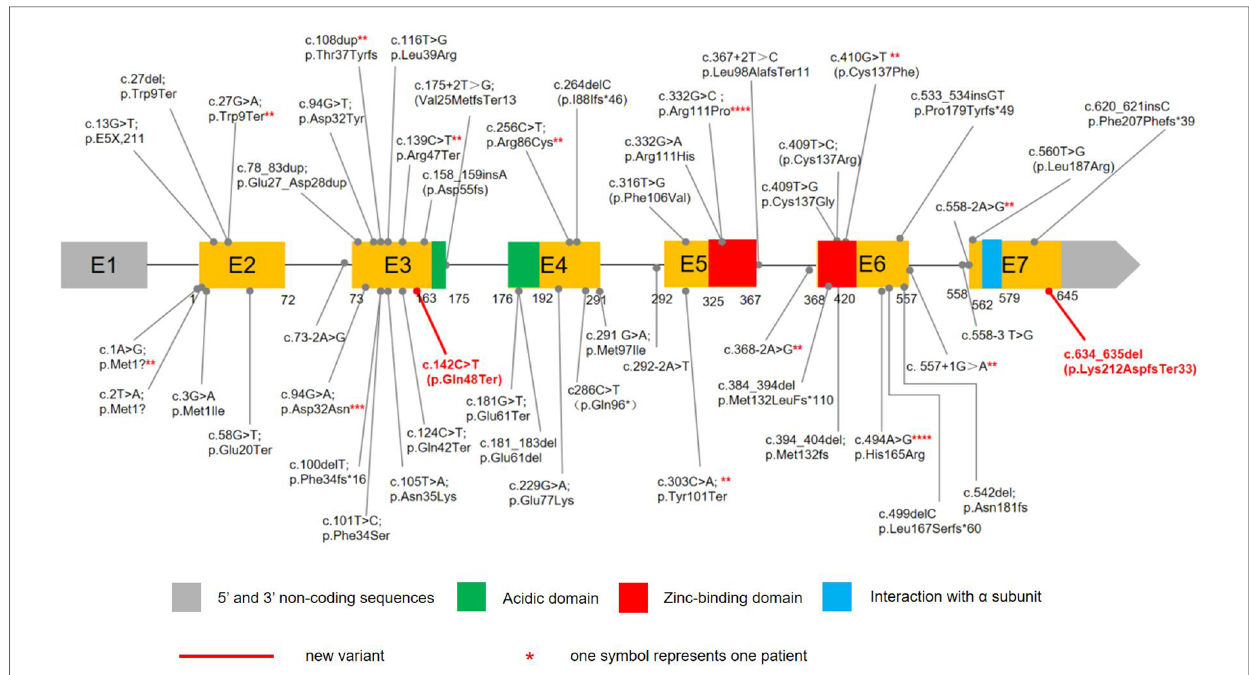
FIGURE 2 The variants in CSNK2B DNA sequence. 65 children with POBINDS caused by CSNK2B variants have been reported, with various mutation types, including missense, nonsense, splice site, start loss, frameshift, and in-frame duplication mutations. Our cases had two de novel variants. c.634_635del was a mosaic variant, c.142C>T was a nonsense mutation.